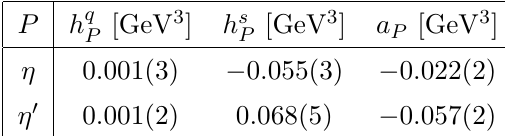
Table 3 . Hadronic inputs for (cid:17) and (cid:17) 0 obtained in refs. [97, 98] by using the FKS mixing scheme. The best available computation of a Kroll-Stech (FKS) mixing scheme [97]. This phenomenological approach is based on the assumption that the states anomaly. In this case, by using inputs such as the mixing angle between (cid:17) and (cid:17) 0 , the authors of refs. [97, 98] obtained the inputs collected in table